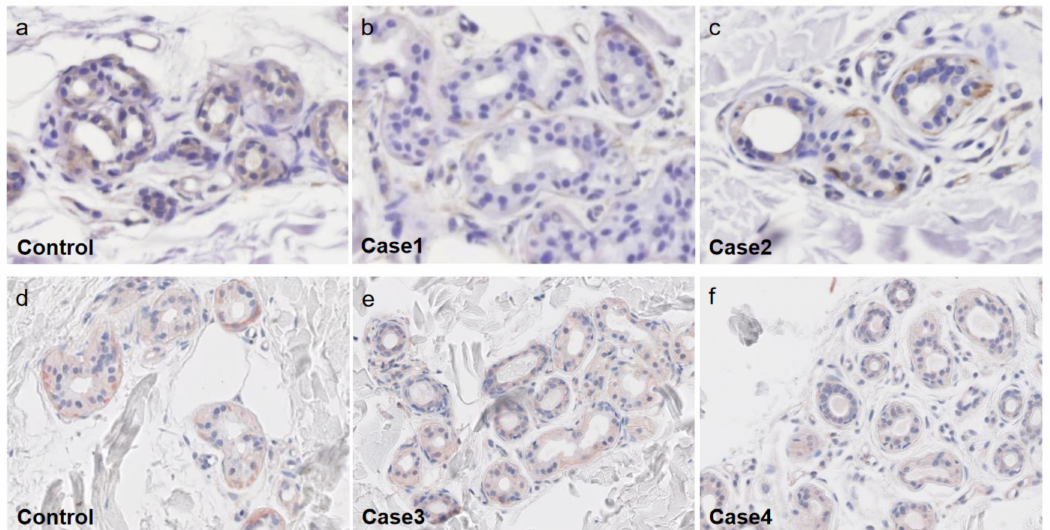
Figure 4. Immunohistochemical staining of cholinergic receptor M3 (CHRM3) at the anhidrotic area in our cases. The upper and lower columns were stained independently. Decreased expression of the CHRM3 (brown signals) is observed in sweat gland epithelial cells ( b , c , e , f, original magnification × 200, × 200, × 100 and × 100 respectively) compared with control ( a , d, original magnification × 200 and × 100